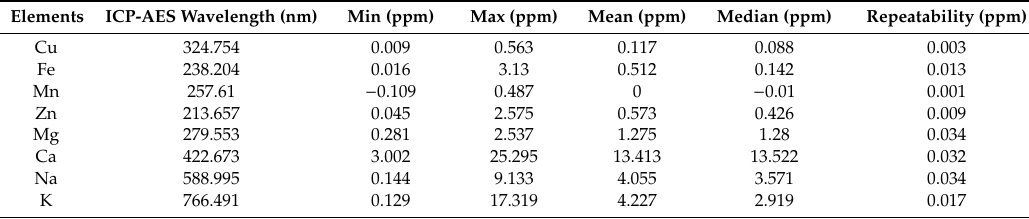
Table1. MineralelementsexpressedasppminaqueousINFsamples( n = 83)determinedusingICP-AES. Elements ICP-AES Wavelength (nm) Min (ppm)